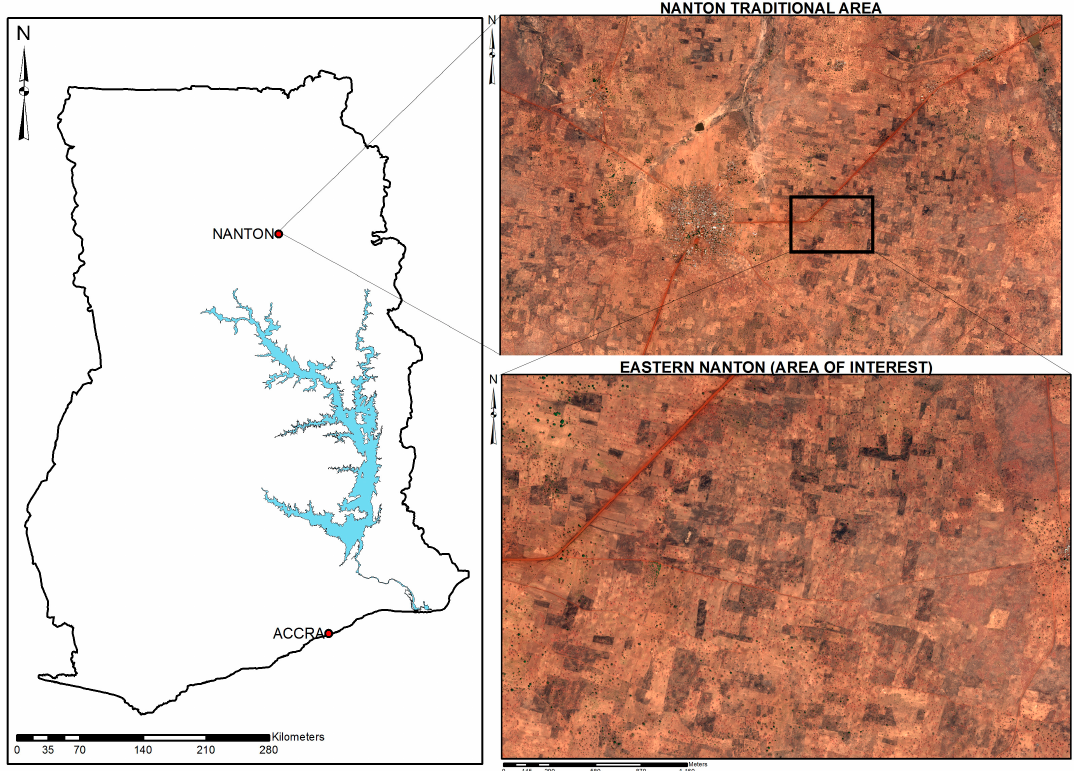
Figure 2. Map showing the area of interest in the Nanton Traditional Area and Ghana (Satellite image courtesy of DigitalGlobe Foundation).